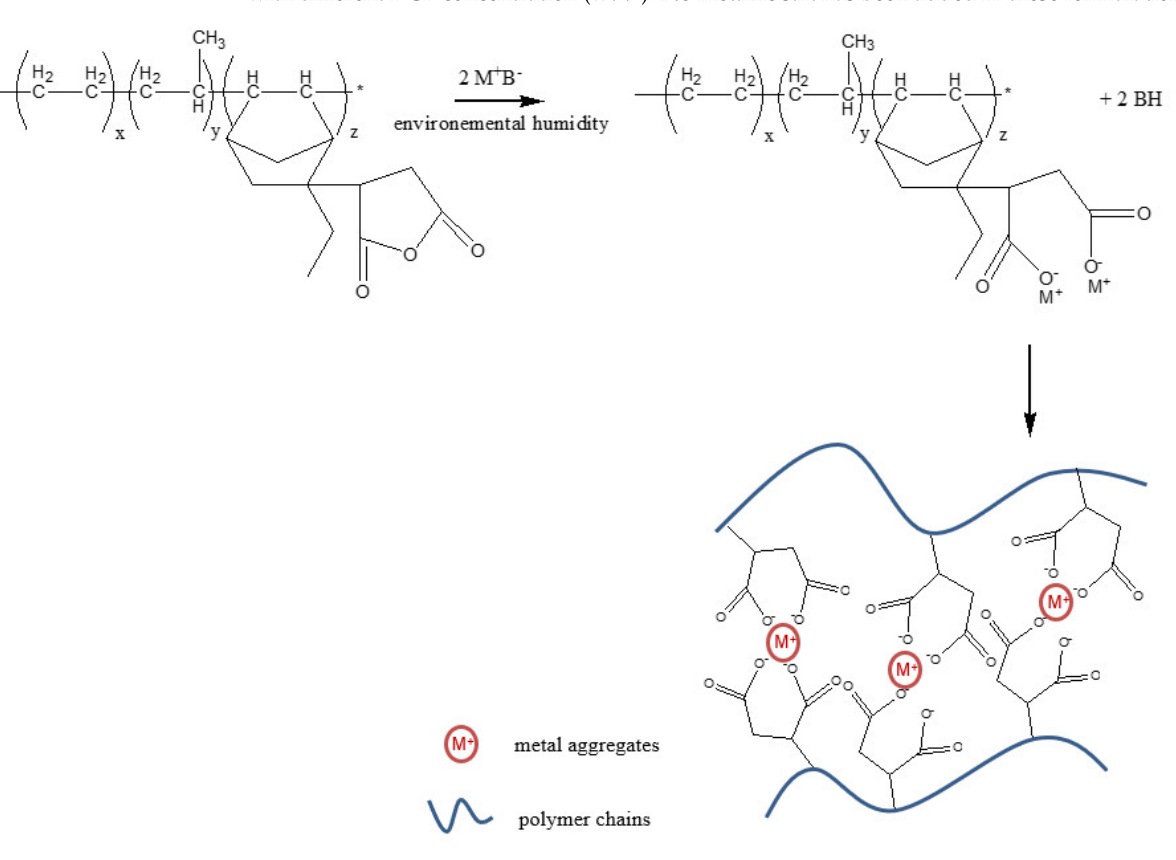
Figure 3. EPDM-g-MA neutralization step, according to Li et al. [30].